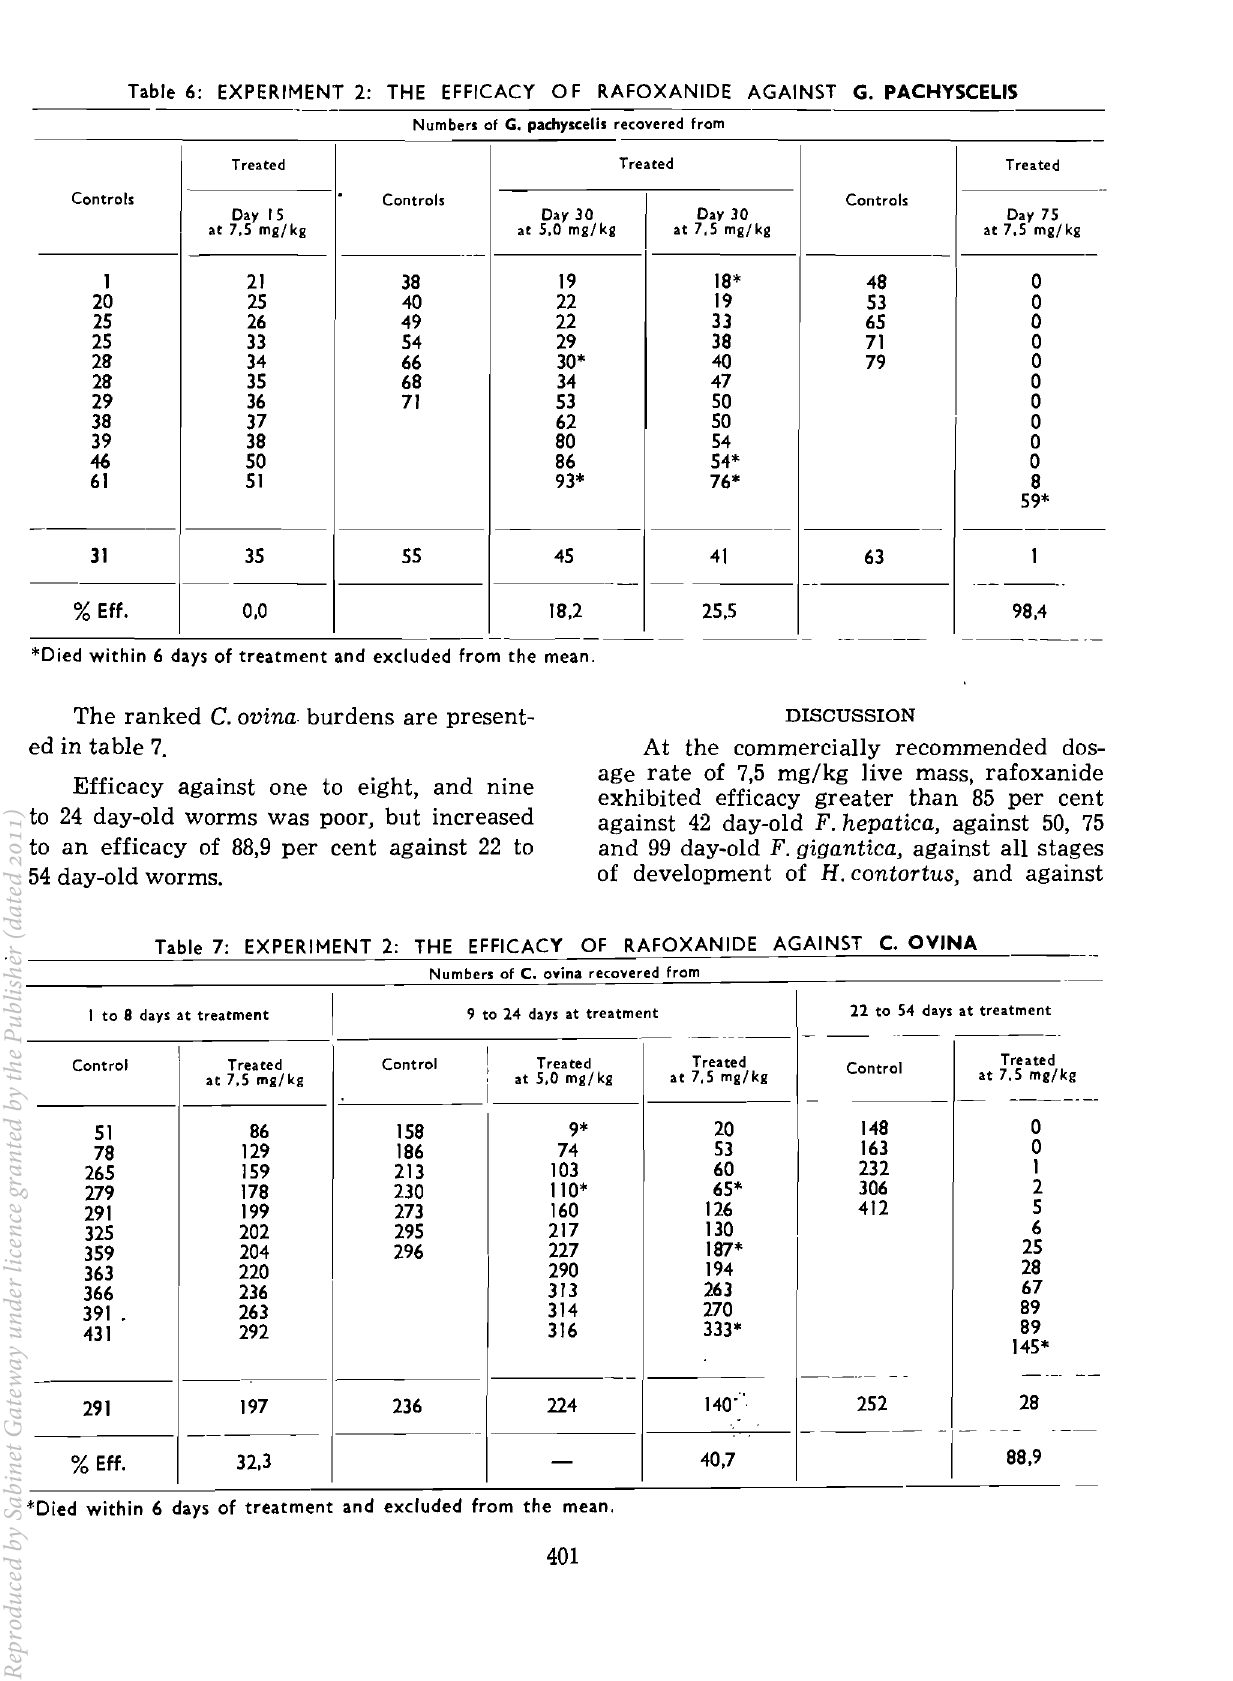
Table 6: EXPERIMENT 2: THE EFFICACY 0 F RAFOXANIDE AGAINST G. PACHYSCELIS Numbers of G. pachyscelis recovered from